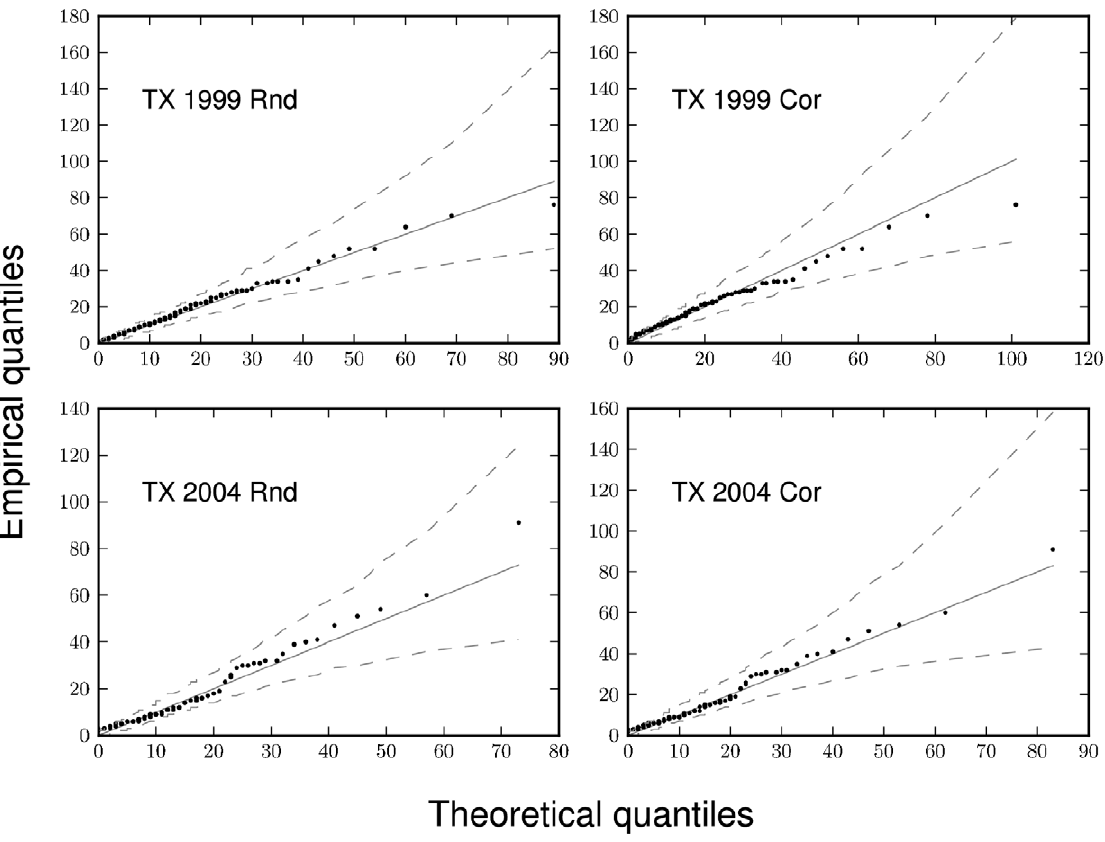
Figure 3. Bayesian fits of the model to the four TX grid datasets, as visualized with quantile-quantile plots. The ‘‘expected’’ distribution (solid lines) under the fitted accumulation model, as well as the 95% credible regions (dashed lines) around the predicted line, were generated via posterior predictive simulations.